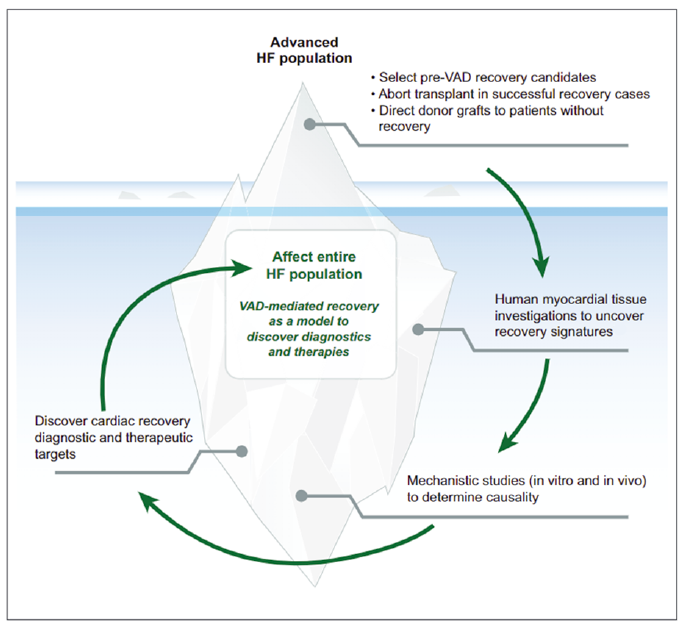
Figure 4. Extrapolating the lessons learned from patients with ventricular assist devices to the broader heart failure population. Reprinted with permission from Taleb I, et al., (2022), Copyright © 2022, Wolters Kluwer Health [65].